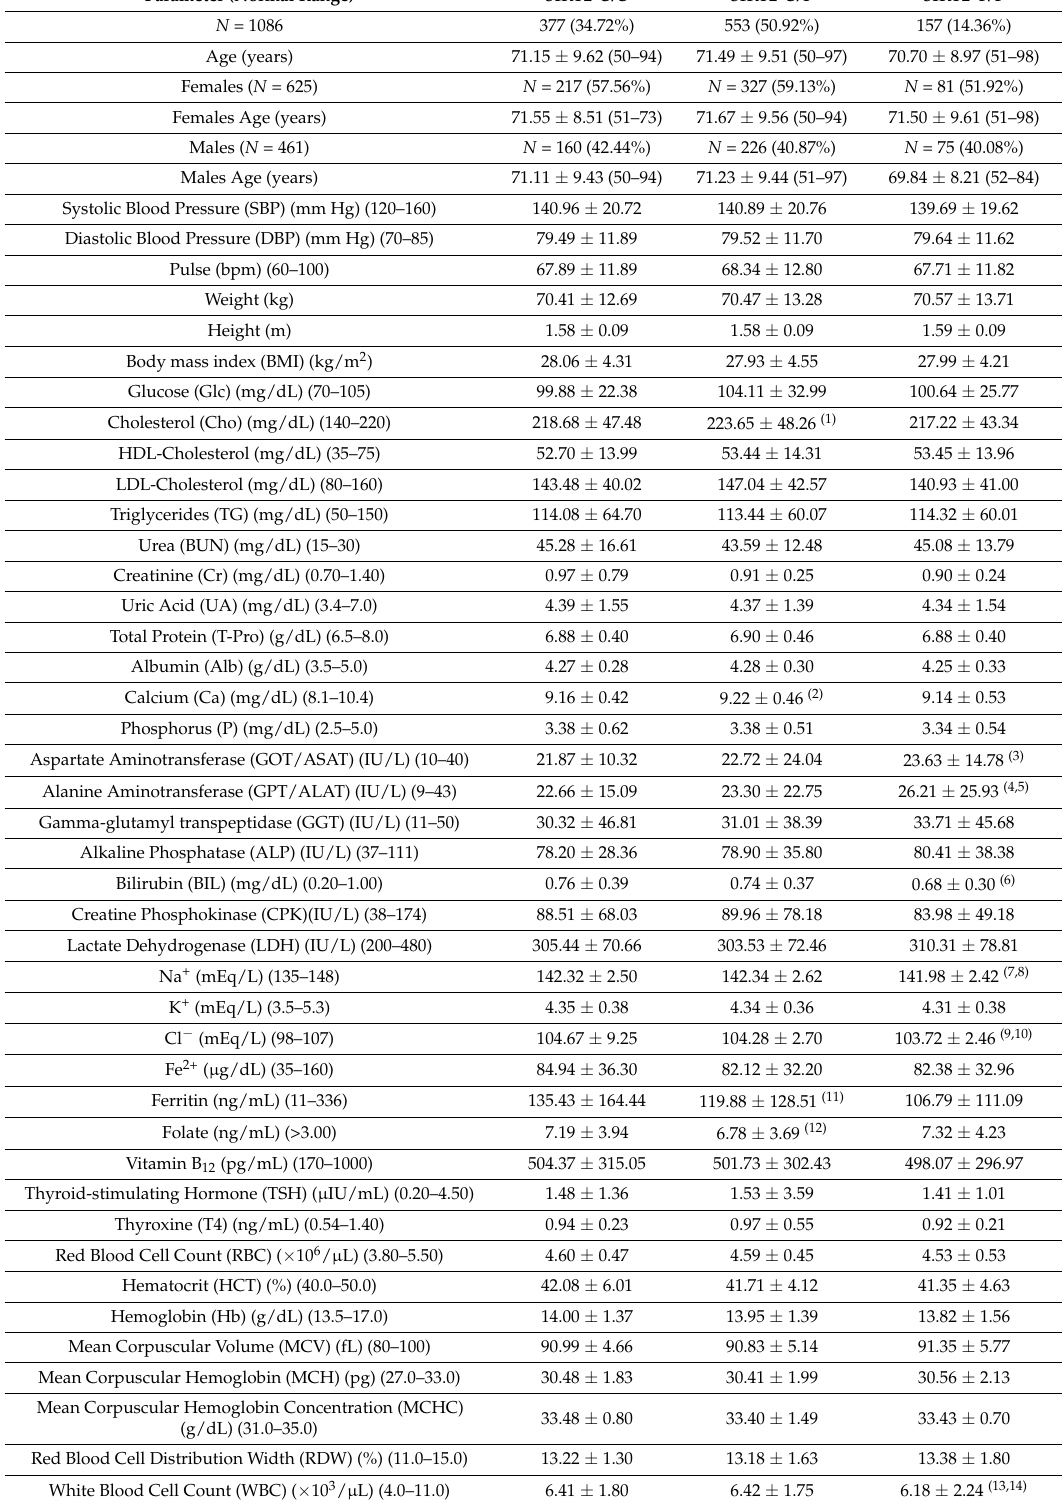
Table 2. SIRT2-related phenotypes in patients with Alzheimer’s disease. Parameter (Normal